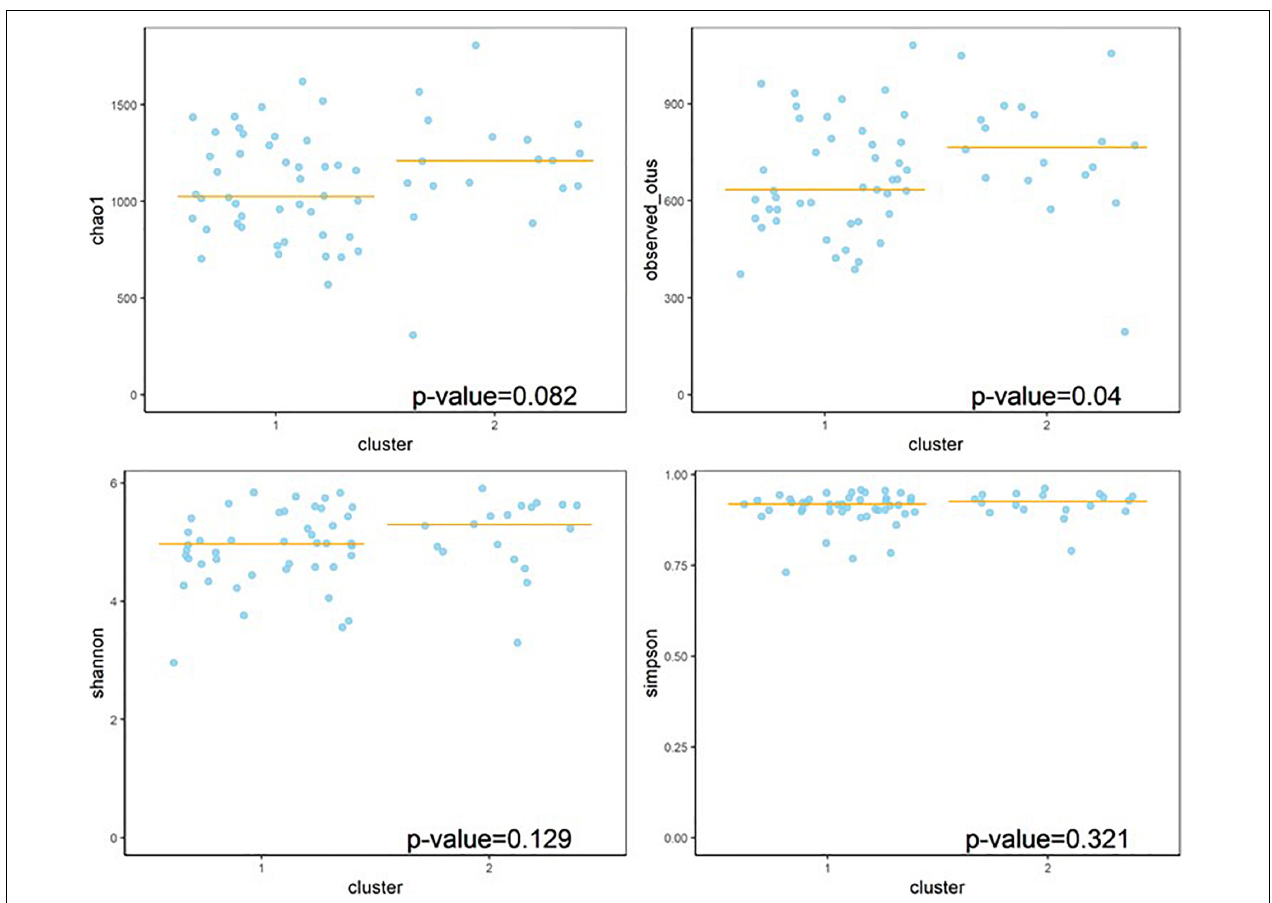
FIGURE 4 | Alpha diversity between clusters (wunifrac